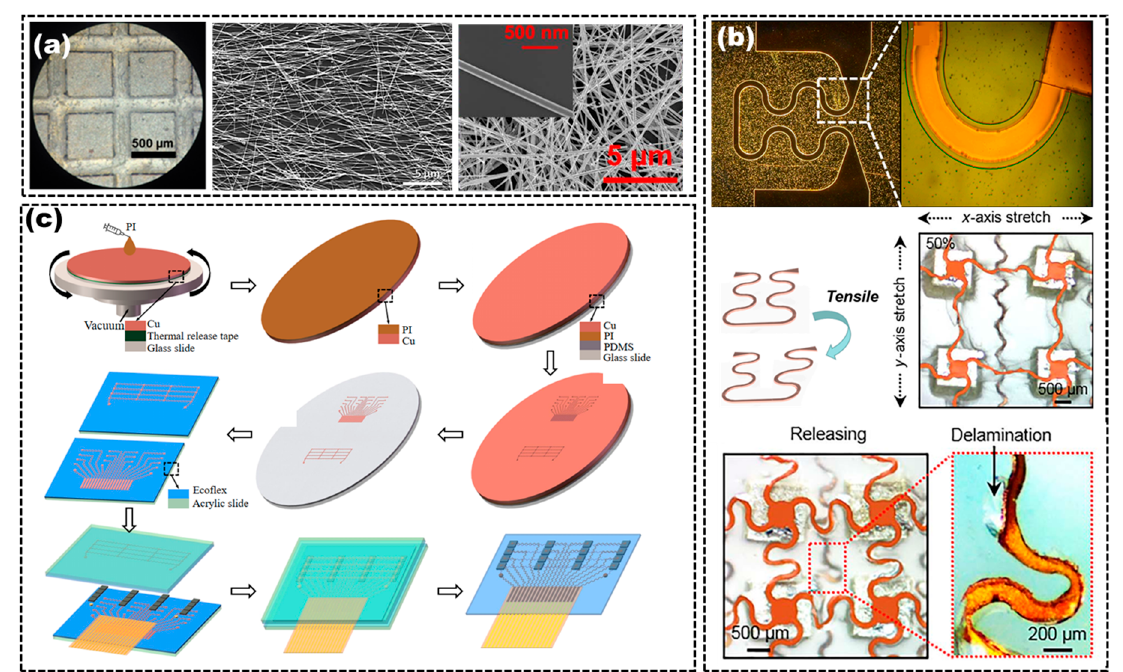
Figure 2. ( a ) Optical image of the AgNW electrode on the transducer ( left ), SEM image of the AgNW film ( middle ) and SEM image of AgNWs at high magnifications ( right ). Adapted from [21,24]. ( b ) Electrode patterned as serpentine structures ( top ), schematic diagram of electrode stretching ( middle left ), optical images of the electrode in stretched ( middle right ) and relaxed states ( bottom ). Adapted from [23,42]. ( c ) Fabrication process of patterning stretchable electrodes with a laser. Adapted from [44] .